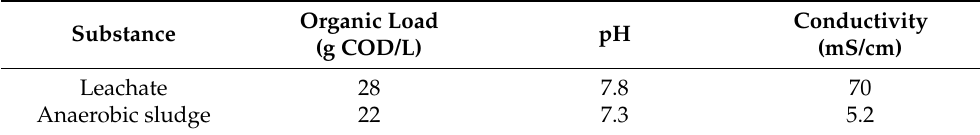
Table 1. Characteristics of processed leachate and anaerobic sludge used in the MFC.